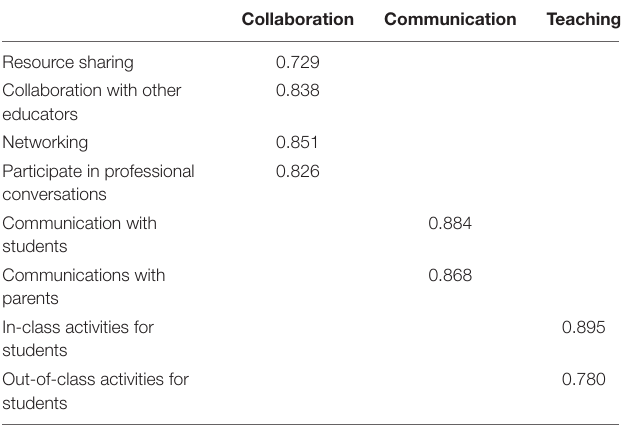
TABLE 2 | Coefficients on three factors on the impact of social media on professional